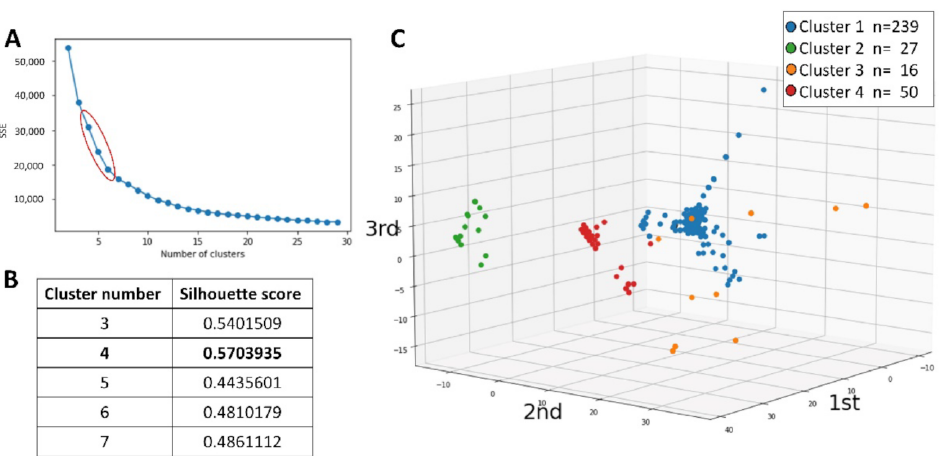
Figure 4. Results of clustering. ( A ): The elbow chart calculated by k-means++, suggesting four to six is the appropriate number of clusters. ( B ): The silhouette score was calculated, and that of the 4 clusters was highest as 0.5704. ( C ): The clusters are plotted in the three-dimensional space, of which the axes were calculated by the principal component analysis consisting of the 25 variables. SSE; sum of squared